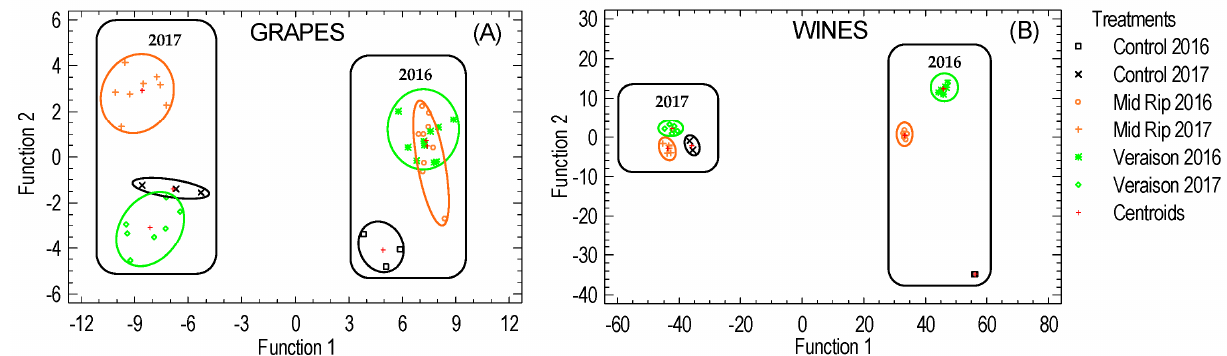
Figure 4. Distribution of the grape ( A ) and wine ( B ) samples in the coordinate system defined by the discriminants functions used to differentiate among treatments.